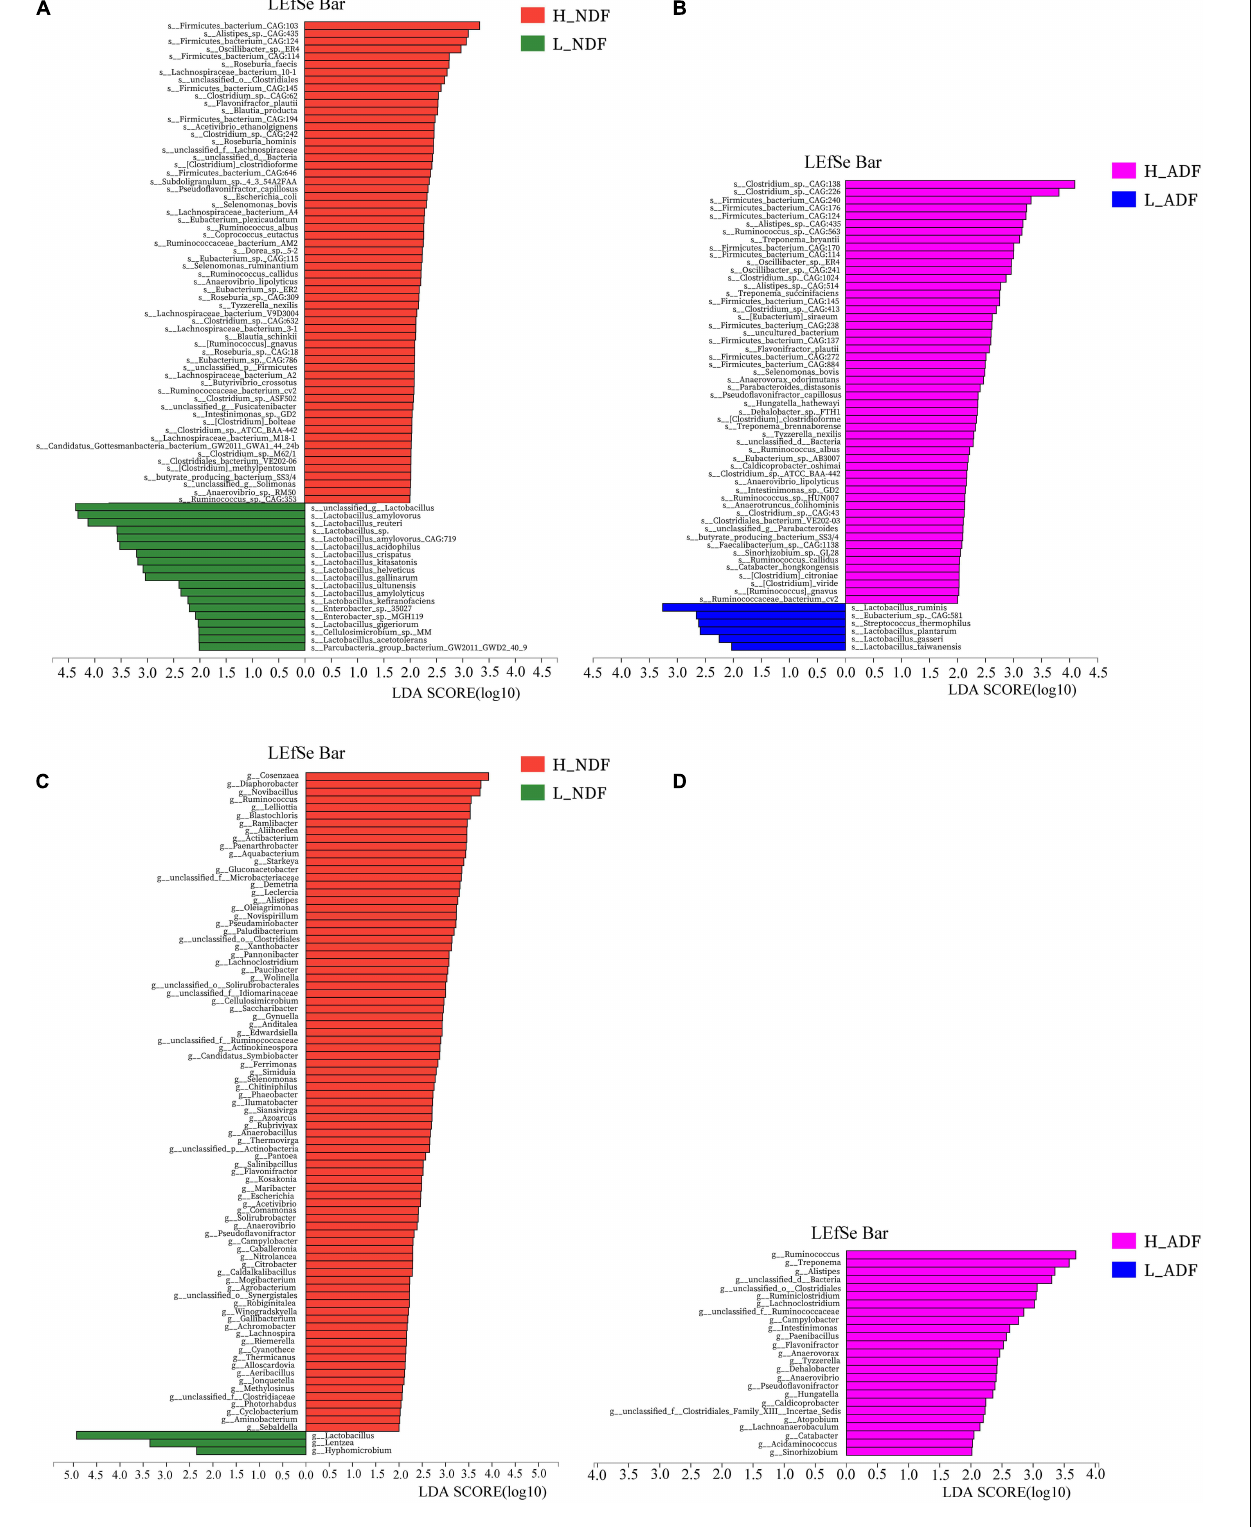
FIGURE 3 | LEfSe analysis was performed to identify the species and genus in each sample that is closely contribute to fiber digestion with the greatest contribution. Significant species (A,B) and genus (C,D) identified by LEfSe were displayed ( P < 0.05, LDA score > 2).